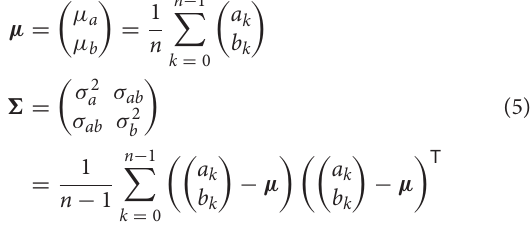
a ∗ b ∗ plane of the CIEL ∗ a ∗ b ∗ space. We use a bivariate normal distribution as a statistical model for describing these